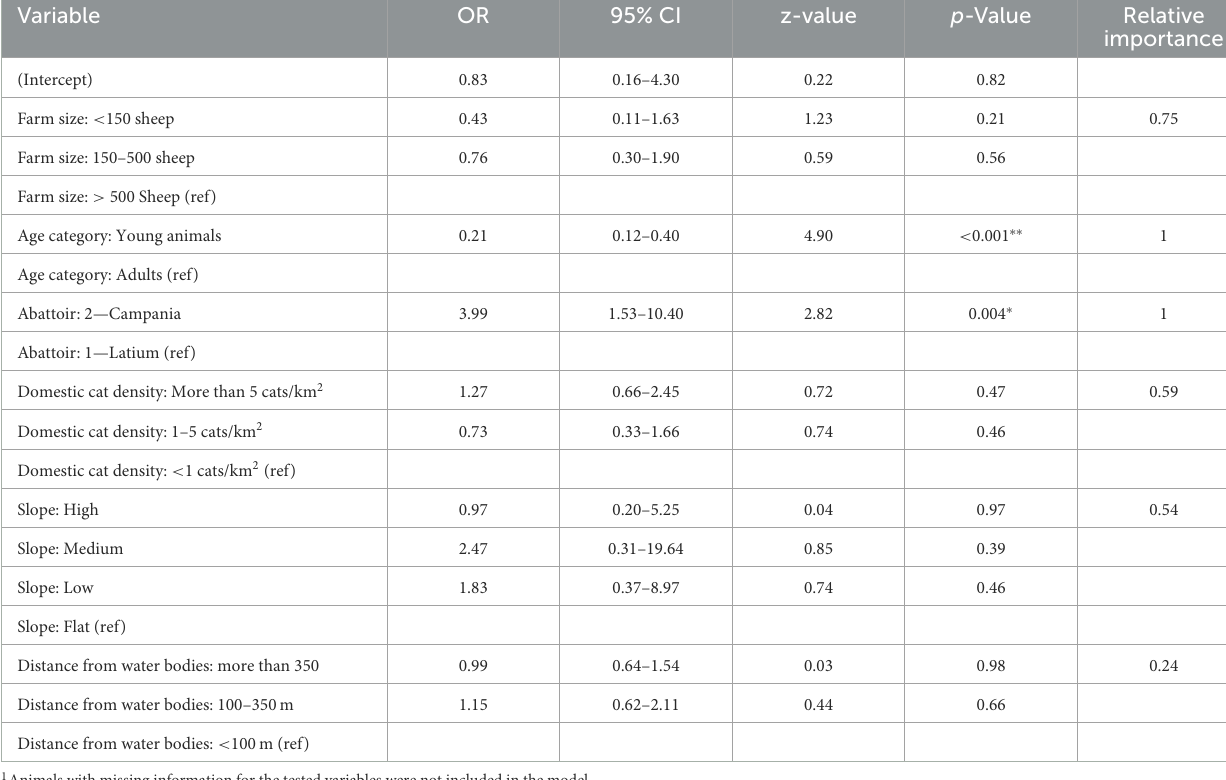
TABLE 2 Multinomial logistic regression analysis of risk factors associated with Toxoplasma gondii infections in sheep ( n = 340) 1